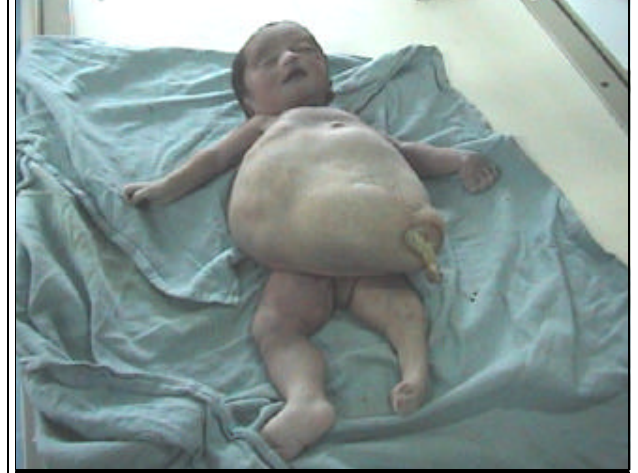
Fig. 1 : Prominent abdomen with bulging flanks, hemihypertrophy of right side and Talpes equinovarus